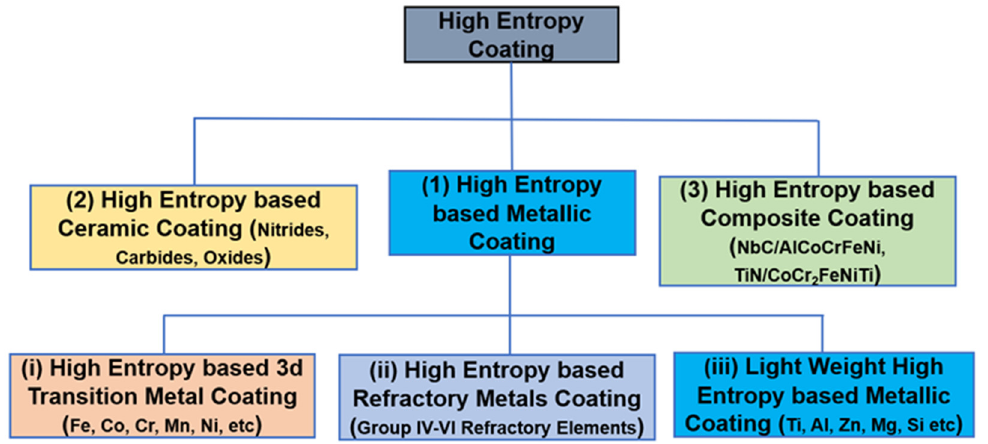
Figure 1. Classification of high-entropy coatings based on composition (3d stands for 3d block of elements, while groups IV–VI are refractory elements in the periodic table). Table 1. Summary of different high-entropy-based coating materials deposited by conventional coating deposition techniques investigated for desired properties.